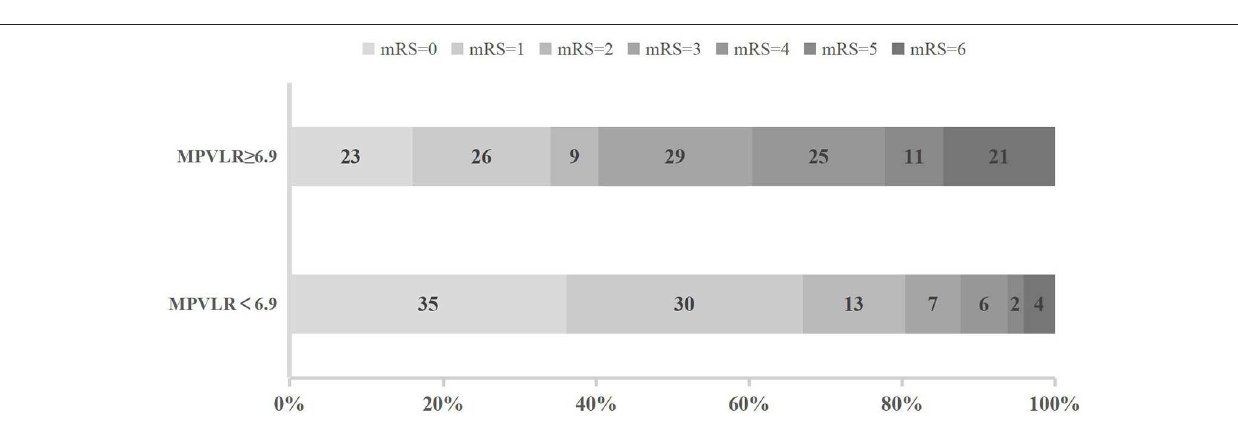
FIGURE 3 | Functional outcomes at 3 months in groups stratified according to the cutoff value of mean platelet volume-to-lymphocyte ratio (MPVLR) at 18–24h after recombinant tissue plasminogen activator